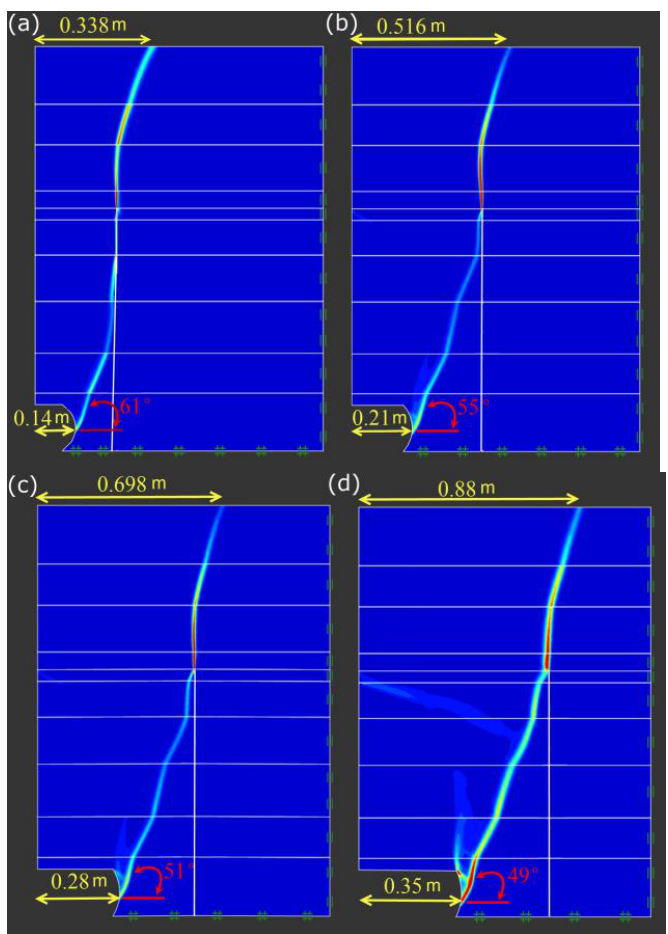
Figure 12. Variation of slope failure surface under four scour widths: ( a ) scour width is equal to 0.14 m, ( b ) scour width is equal to 0.21 m, ( c ) scour width is equal to 0.28 m, and ( d ) scour width is equal to 0.35 m ( a ).